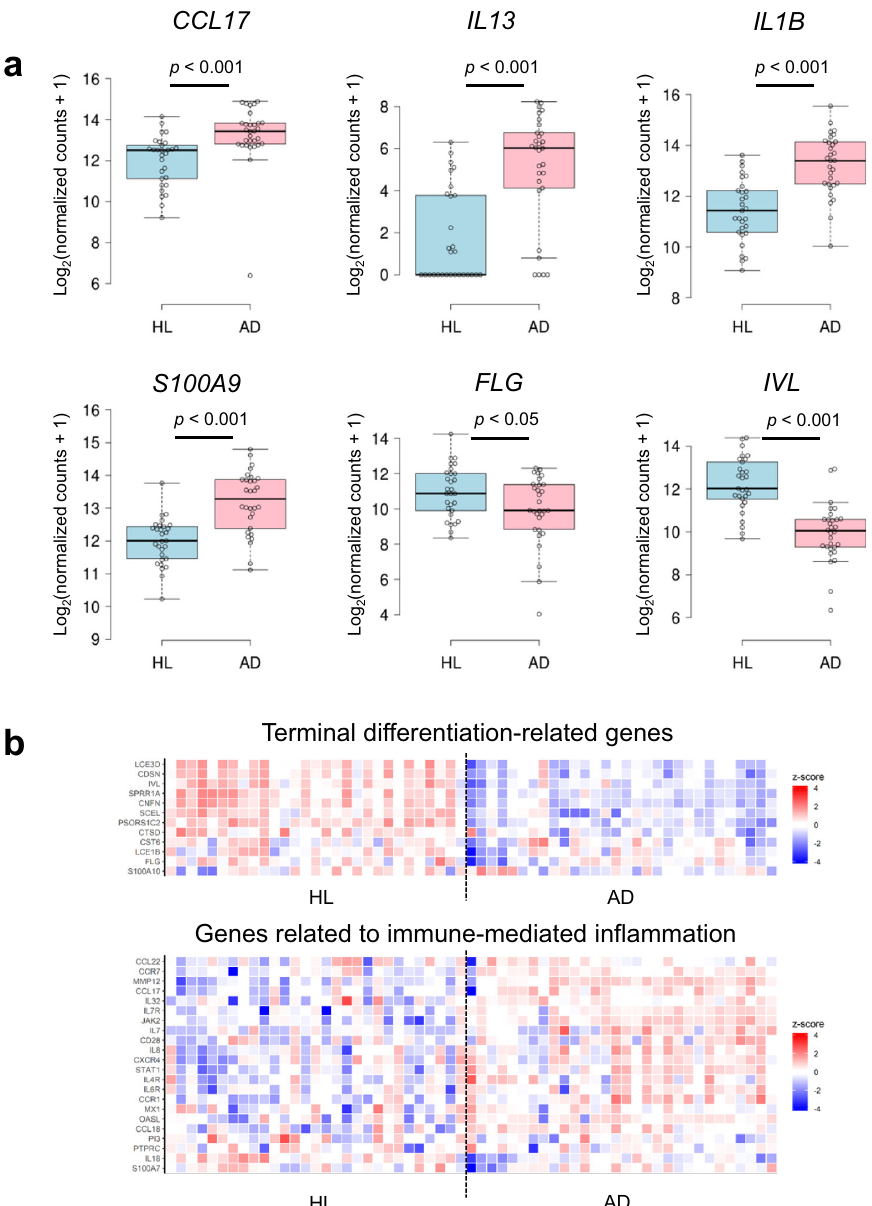
Fig. 5 Comparison of AD marker genes in healthy subjects (HL) and patients with AD. a The differential expression of CCL17 , IL13 , IL1B, S100A9, FLG , and IVL in HL and AD. Boxes represent mean ± interquartile range (IQR), and whiskers represent 1st and 3rd quartile 1.5 * IQR. Benjamini – Hochberg adjusted p values are shown from the likelihood ratio test between HL and AD. HL ( n = 29), AD ( n = 30). b Heat maps using z-transformed log 2 (normalized counts + 1) in 12 terminal differentiation-related genes (upper) and 22 genes related to immune-mediated in fl ammation